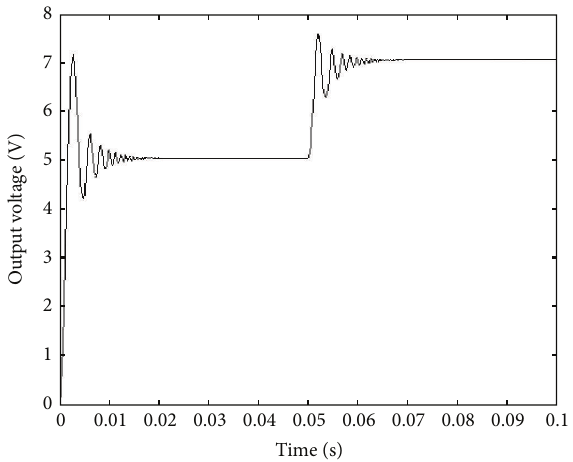
Figure 7: The DC/DC output voltage for a step change in reference voltage in direct control method.